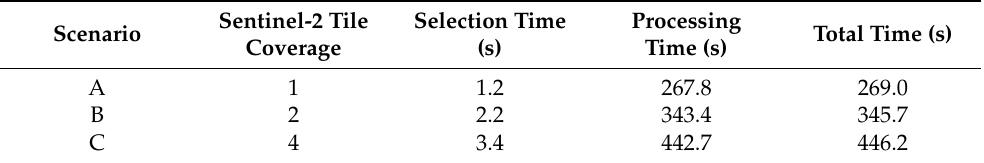
Figure 12. Regions of interest covering one, two and four Sentinel-2 tiles shown by A , B and C , respectively. The Sentinel-2 tile grid is shown in black, with the tile ID at the centre of each tile. Base layer © OpenStreetMap contributors. Table 2. Time requirement for the generation of ARD for regions of interest covering one, two and four Sentinel-2 tiles, shown as A , B and C , respectively, in Figure